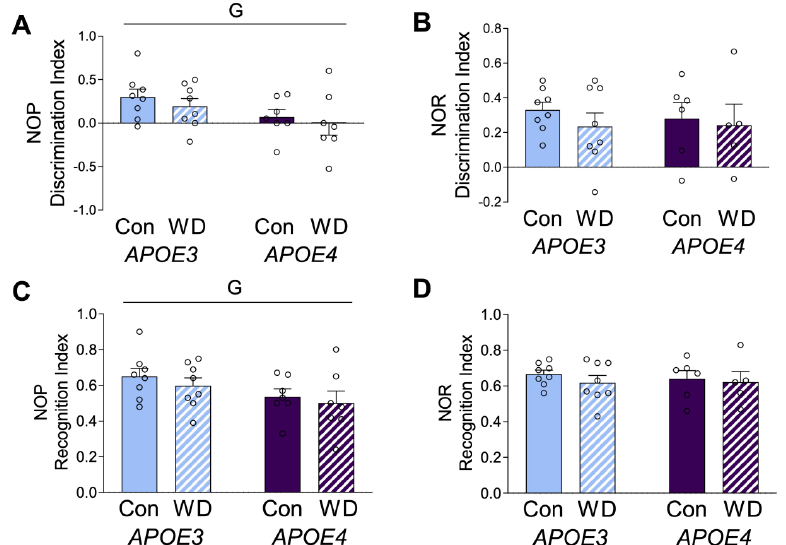
Figure 2. Behavioral effects in APOE mice after the Western diet. Animals were tested with ( A , C ) novel object placement (NOP) and ( B , D ) novel object recognition (NOR) behavioral tasks. The discrimination index is represented in ( A , B ), with values > 0 indicating positive performance. The recognition index is represented in ( C , D ). Data are shown as individual values (open circles) and mean values (+SEM), from n = 5–8 mice per group. “G” indicates a significant main effect of the APOE genotype. Significance is p < 0.05.